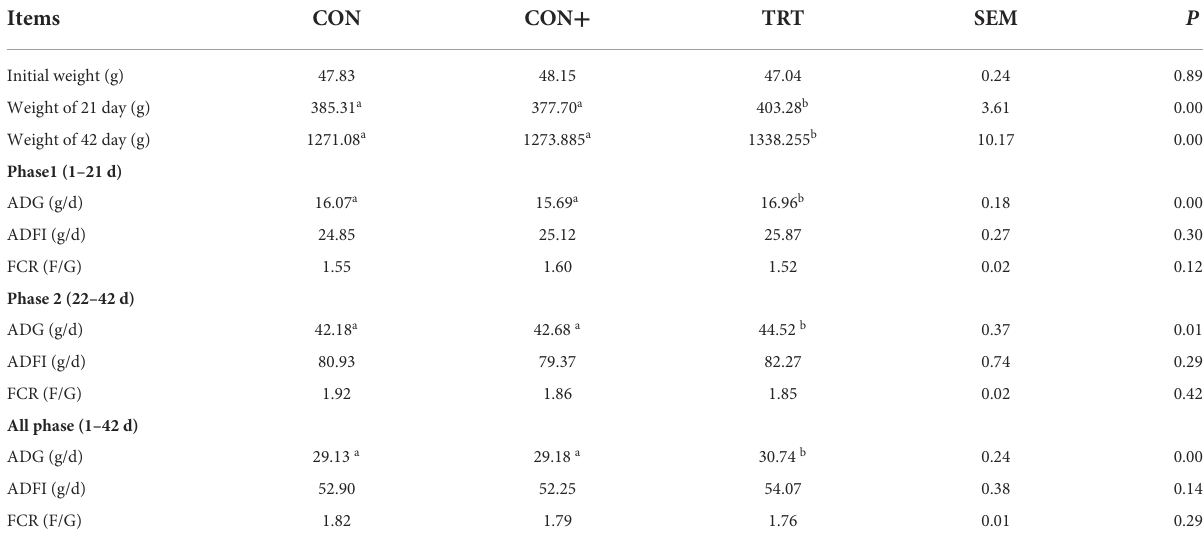
TABLE 3 Effects of different treatments on growth performance in AA broilers.